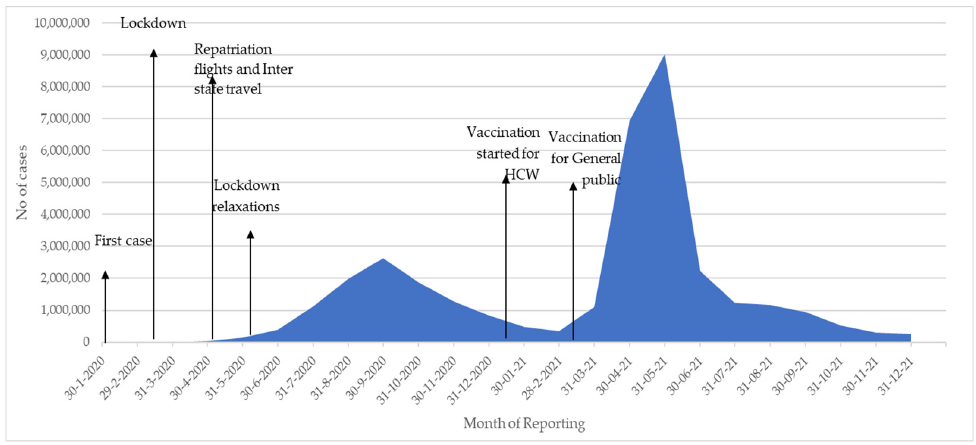
Figure 2. Monthly number of cases of COVID-19 in India, 2020–2021.